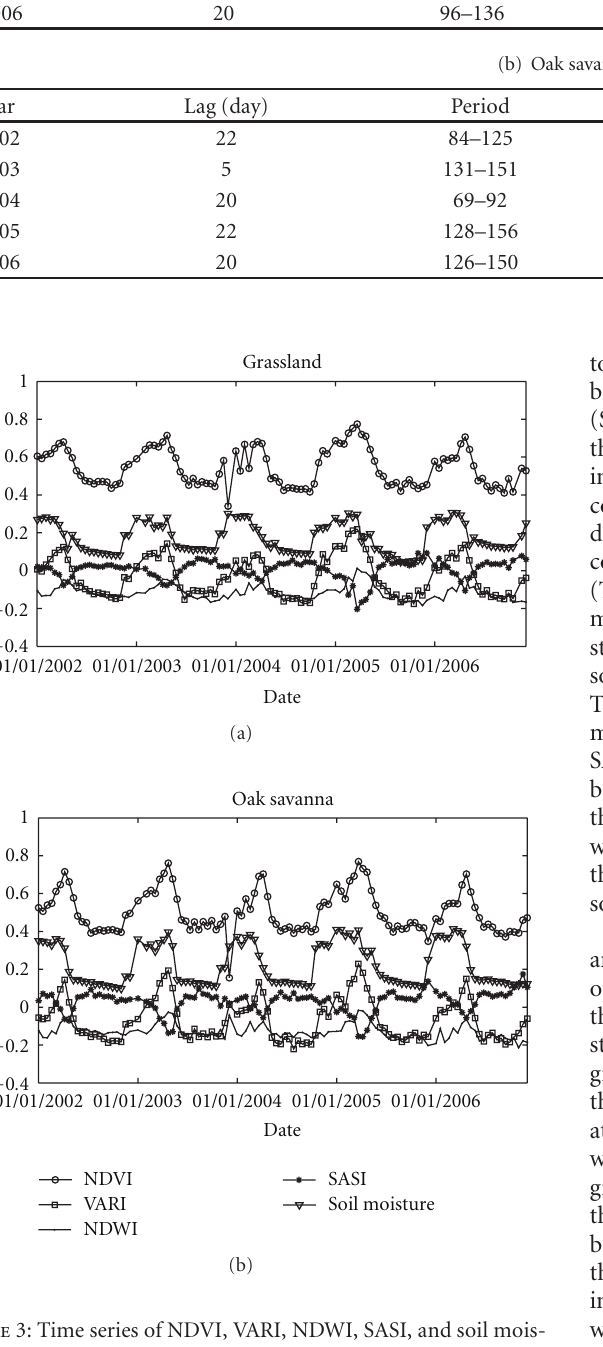
Figure 3: Time series of NDVI, VARI, NDWI, SASI, and soil mois- ture at 10cm in the open grassland (a) and at 20cm in the oak savanna